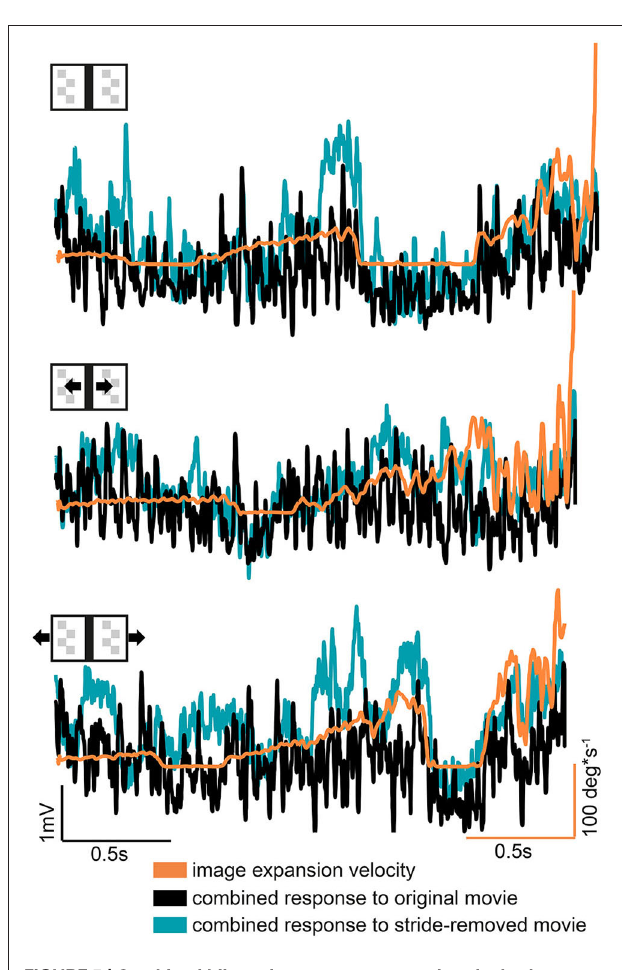
FIGURE 5 | Combined bilateral response compared to the bar’s expansion velocity . The combined response was obtained by summing the responses of both hemispheres after they were normalized separately for motion in the preferred and null direction motion. Note that response and velocity curves have different scales and